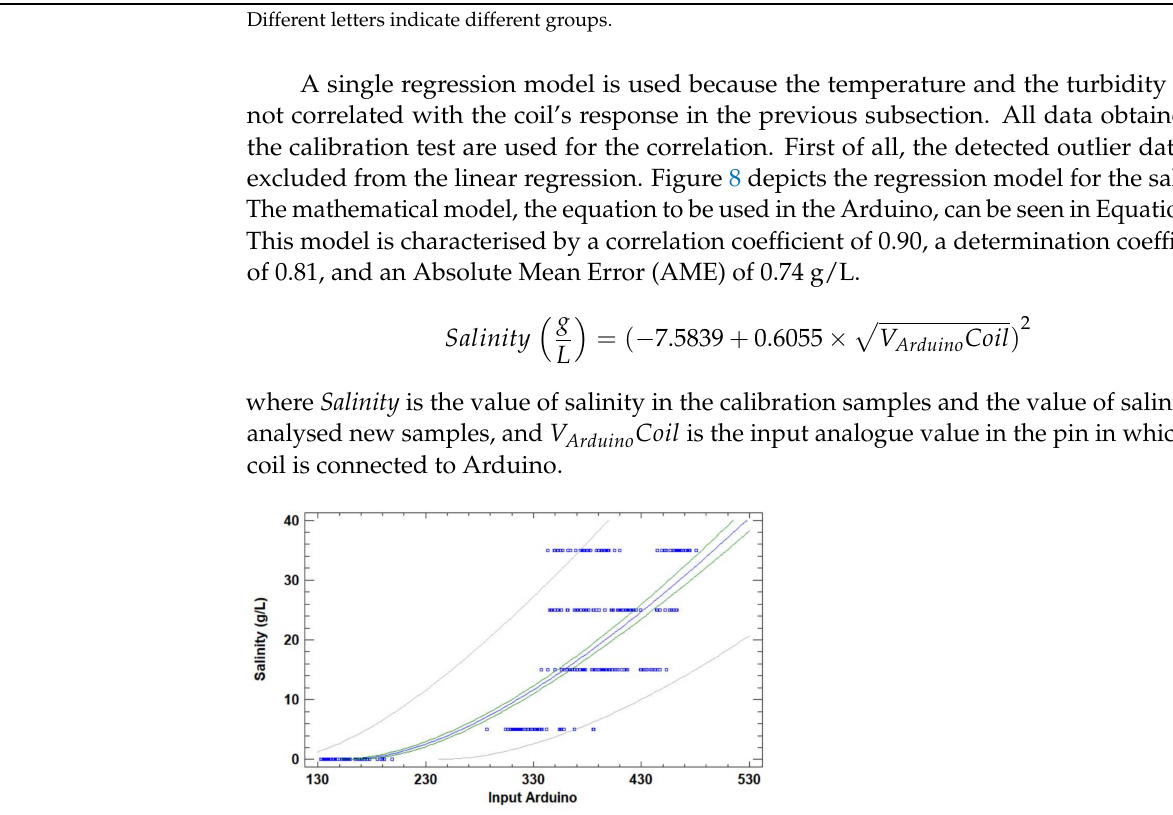
Figure 8. Calibration of the salinity sensor. Blue squares represent the calibration data. The blue line is the mathematical model, the green lines are the confidence interval, and the grey lines are the prediction